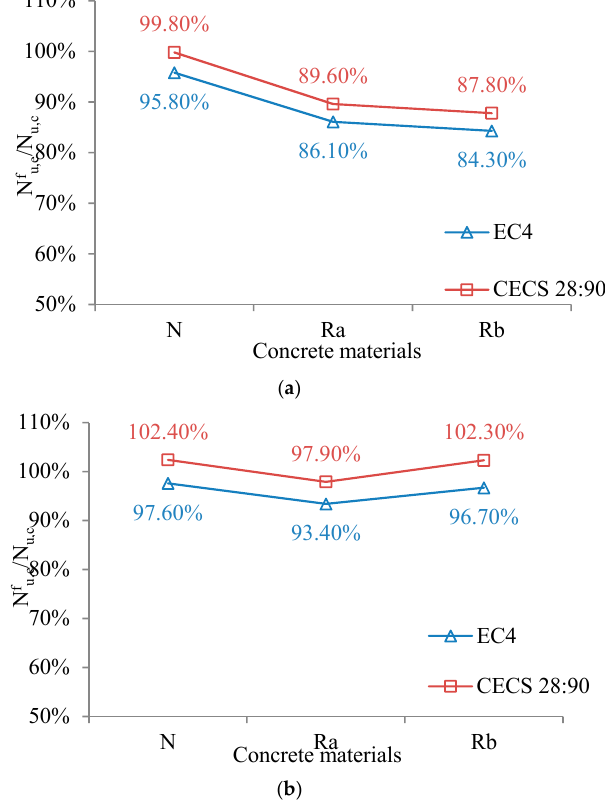
Figure 27. Influence of concrete materials. ( a ) The wall thickness of steel tube is 4 mm; ( b ) The wall thickness of steel tube is 5 mm.